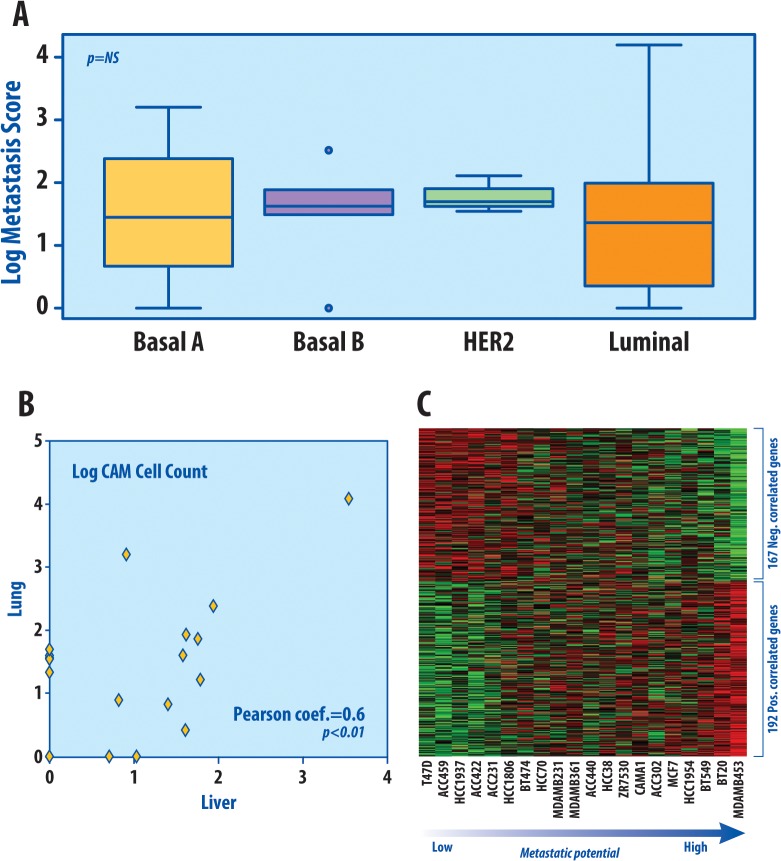
CAM assays.(A) Box plot depicts the metastasis scores of the cell lines grouped by molecular subtype. Metastasis signature scores across breast cancer cell lines were not significantly associated with molecular subtype using ANOVA on the original non-log scores. (B) Scatter plot depicting the log CAM cell counts in the lung and liver, which were highly correlated (Pearson’s correlation coefficient = 0.6, P-value <0.01). (C) Heatmap showing the expression of the genes that were most highly correlated with CAM metastasis score in breast cancer cell that also had a minimum level of expression and internal variability. The genes are ordered by correlation coefficient and the cell lines are ordered by increasing metastatic potential and metastasis score.